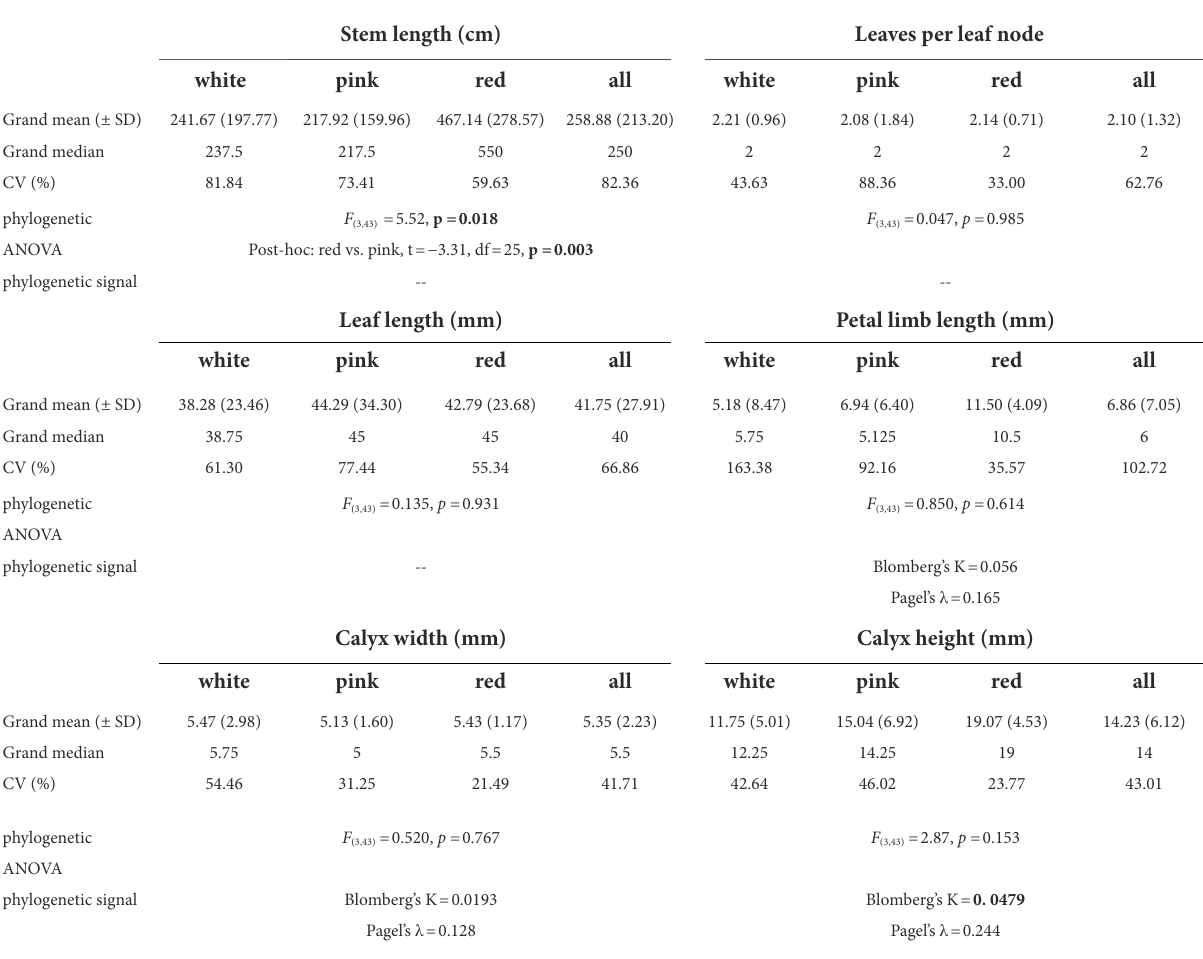
TABLE 1 Summary statistics of continuous floral and leaf traits by floral